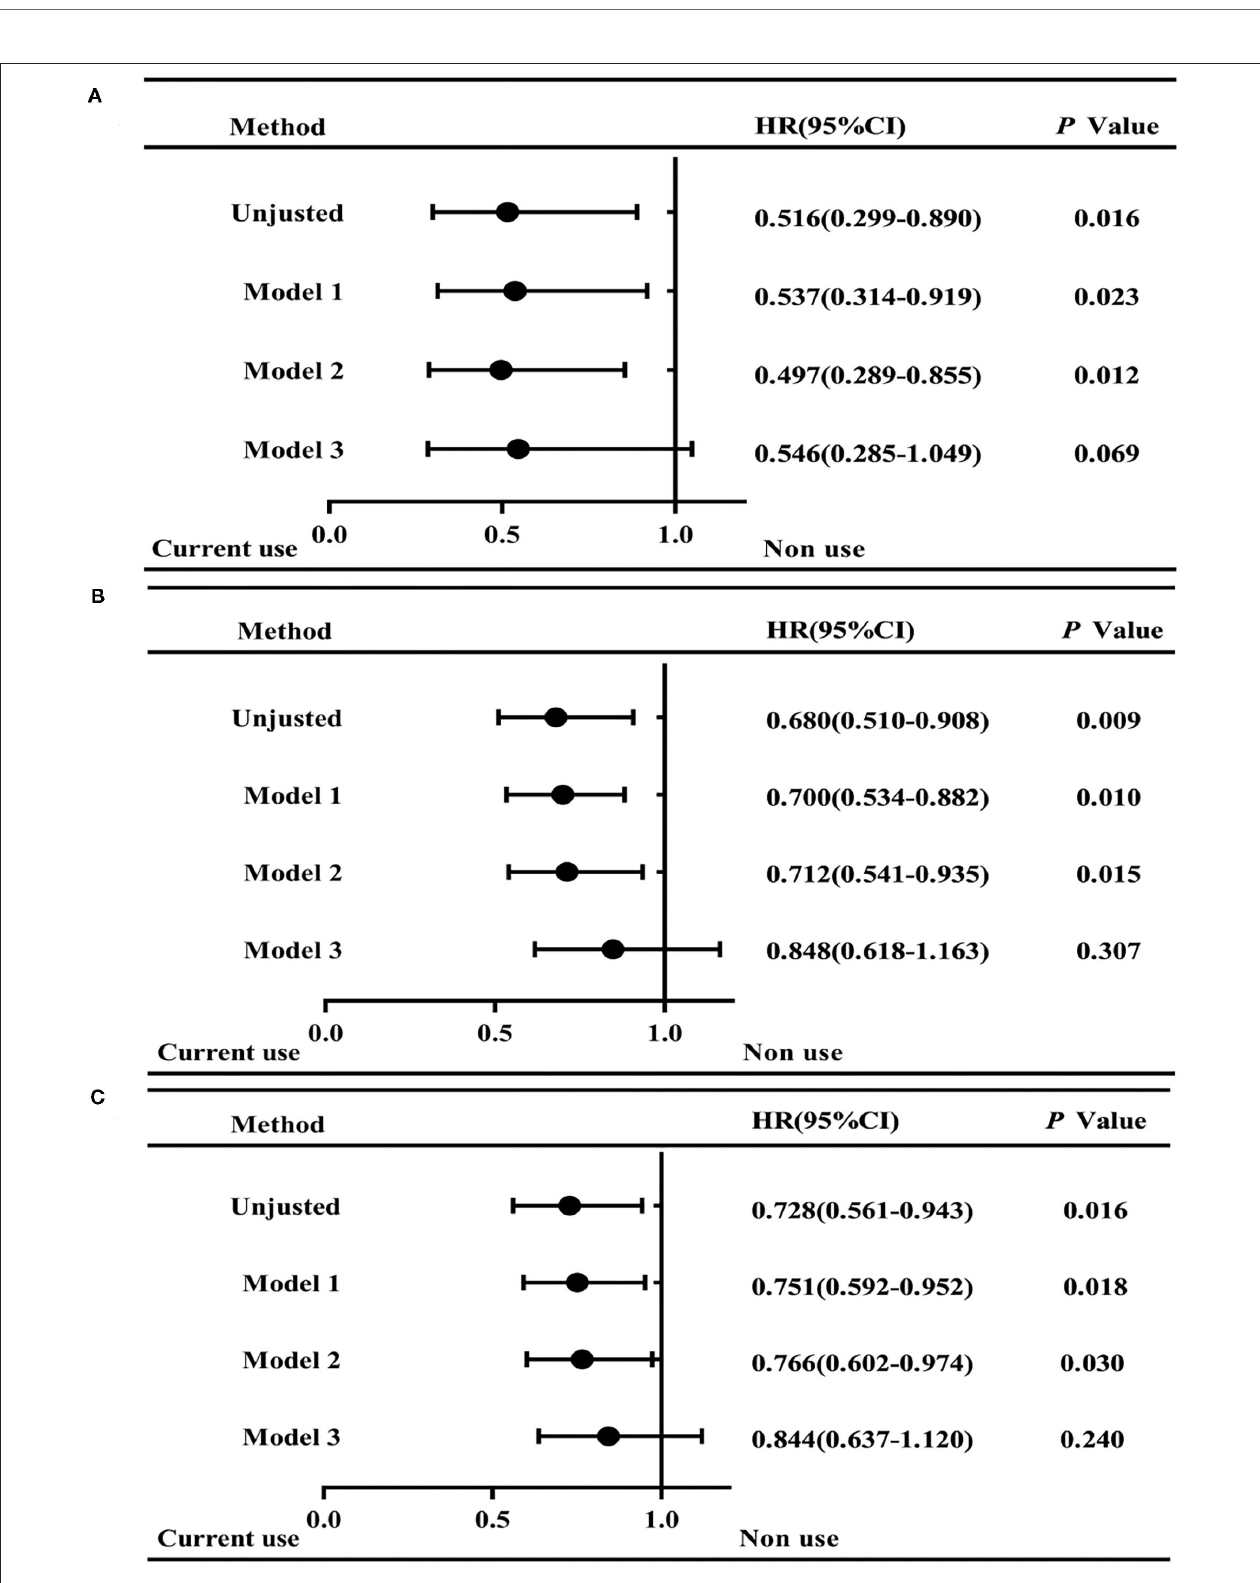
FIGURE 2 | Hazard ratios (95%CI) for mortality in ICH patients of current antihypertension drug use and non-use. Graphs show forest plots for HR for all-cause mortality at discharge (A) , 30 days (B) , and 90 days (C) after ICH onset. Model 1: Adjusted for age and gender. Model 2: Adjusted for age, gender, residence, ischemic stroke history, admission SBP and DBP. Model 3: Adjusted for age, gender, residence, ischemic stroke history, admission SBP and DBP, and hematoma volume. HR, hazard ratio. Non-use group is as the Reference. * p < 0.05.